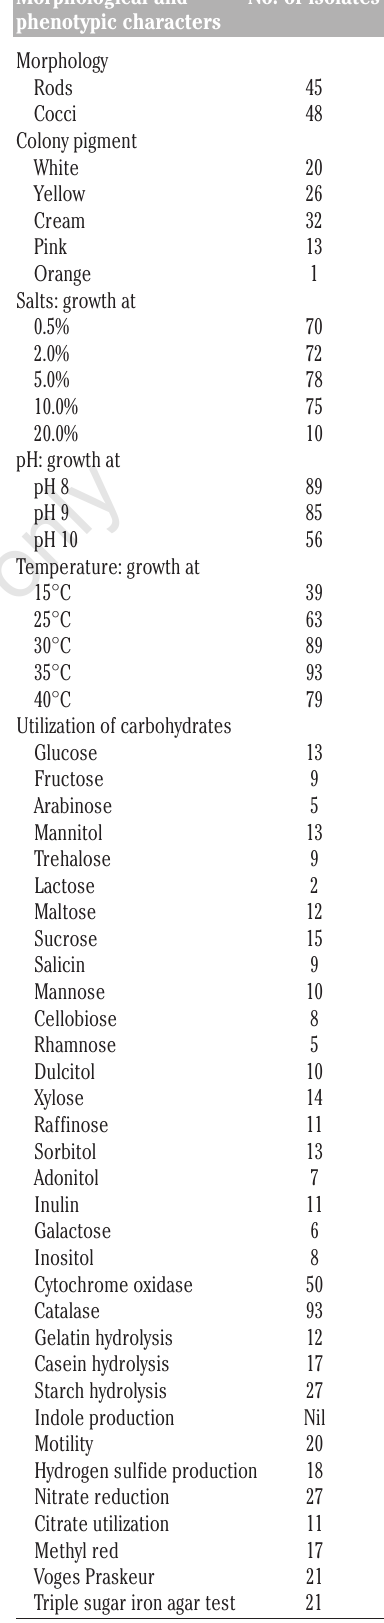
Table 4. Characteristic features of the bac- terial isolates. Morphological